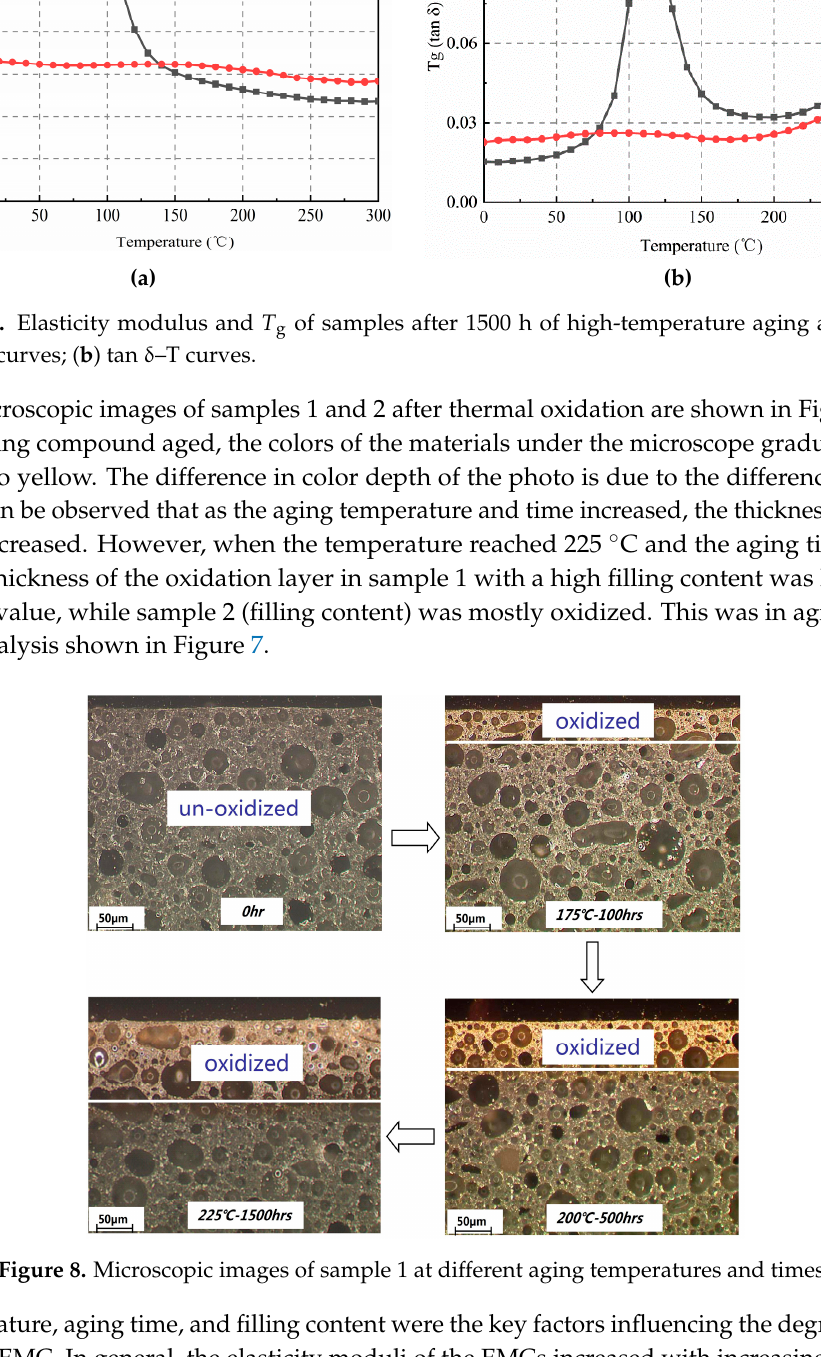
content was low, the corresponding epoxy resin content increased, and the EMC was oxidized more